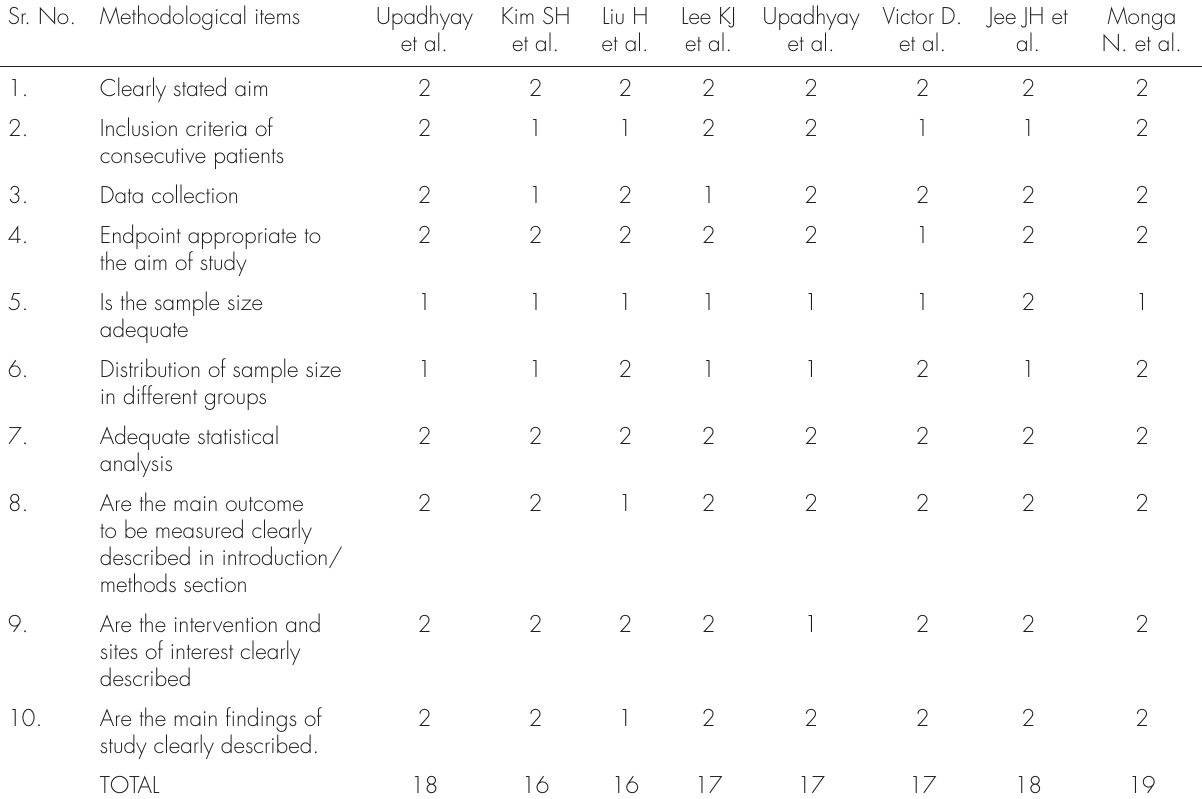
Table V. Quality of studies when mini-implants are used for intrusion and